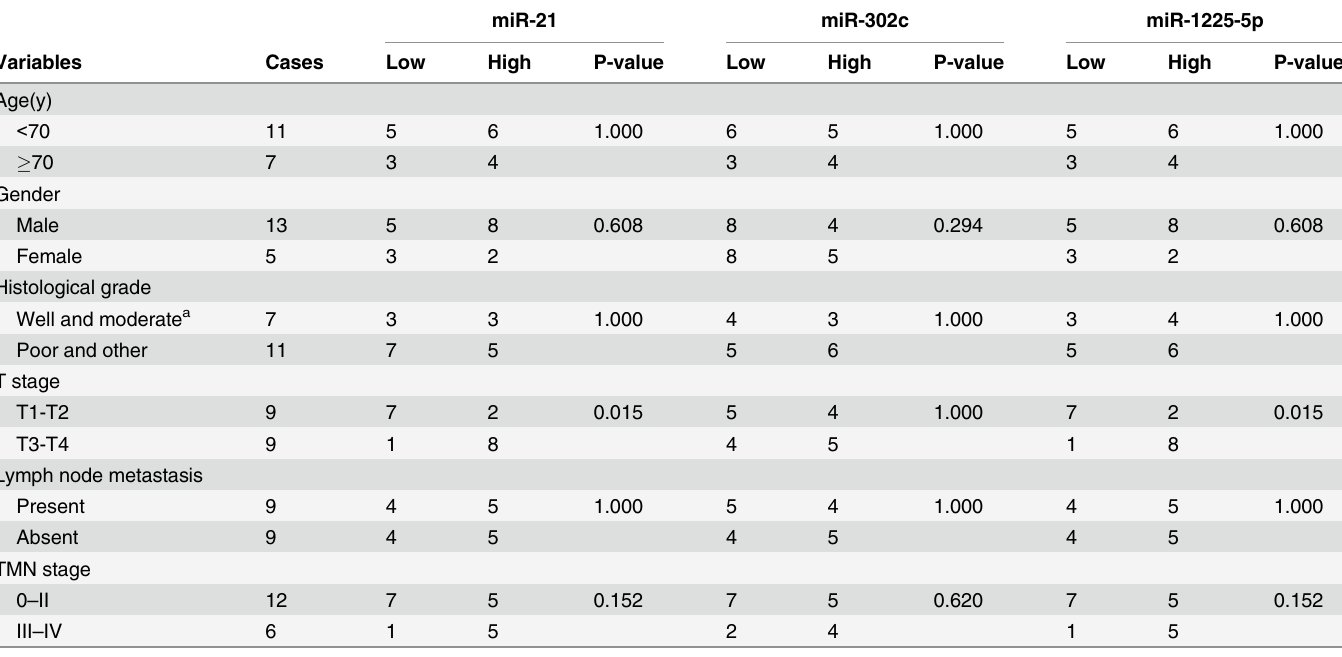
Table 4. Clinicopathological parameters and microRNA